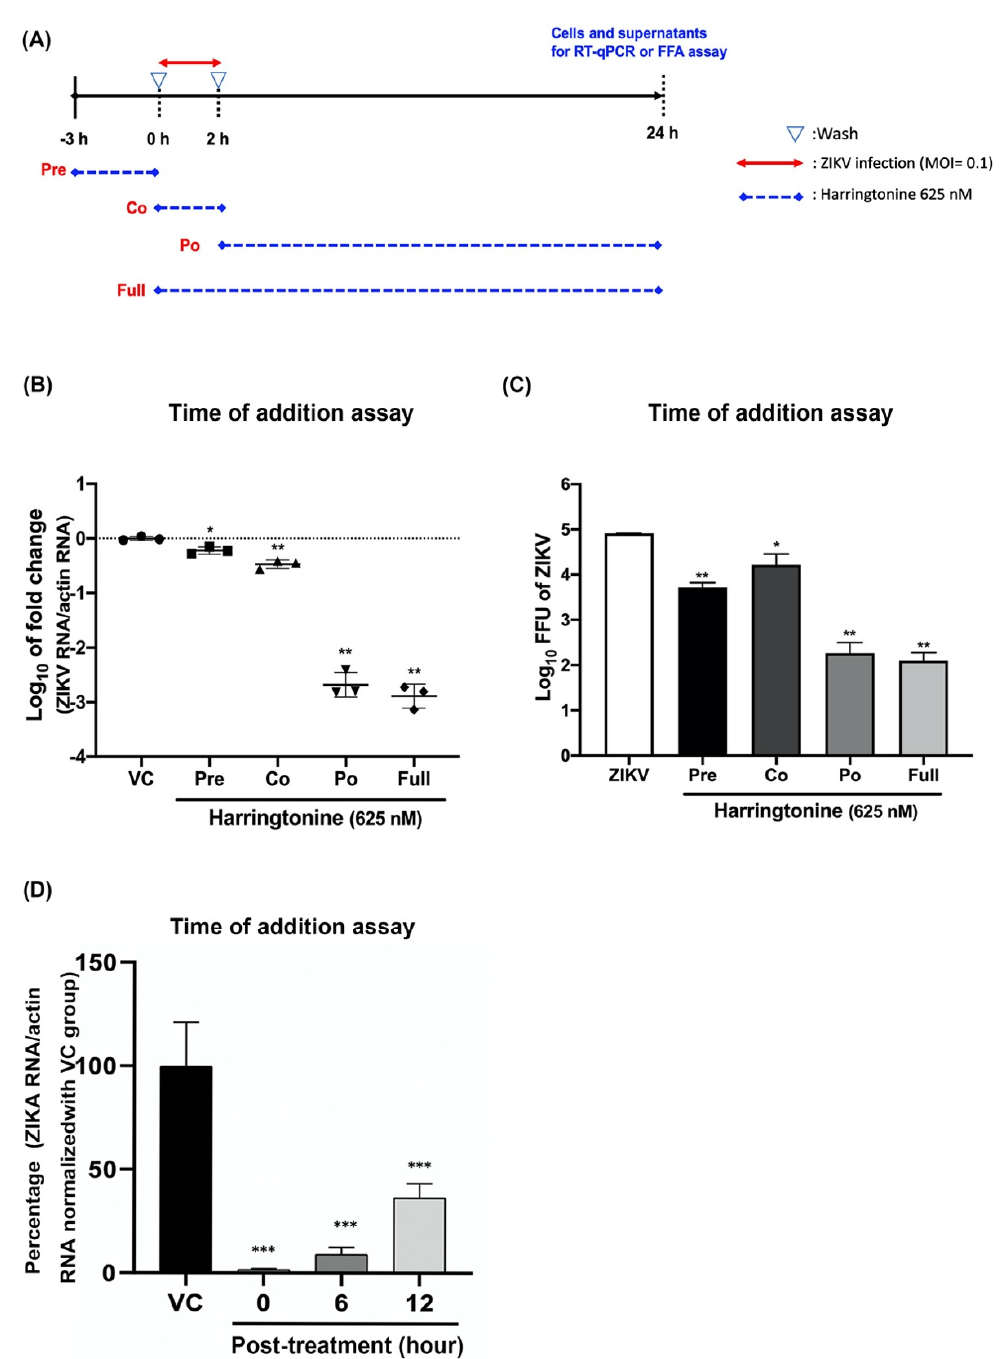
Figure 2. Time of addition assay. Timeline of time of addition assays. The red line refers to the ZIKV absorption period and dotted blue line refers to the harringtonine administration period ( A ). ZIKV RNA levels were determined using RT-qPCR at different infection processes ( B ). Virus titers in supernatants were determined using fluorescent focus assay (FFA) ( C ). The 625 nM of harringtonine was added at 0, 6, and 12 hpi (hour post infection). At 24 hpi, the viral RNA level was analyzed by RT-qPCR ( D ). Statistical significance was analyzed from t -test compared with the ZIKV group: * p < 0.05; ** p < 0.01; *** p < 0.001.